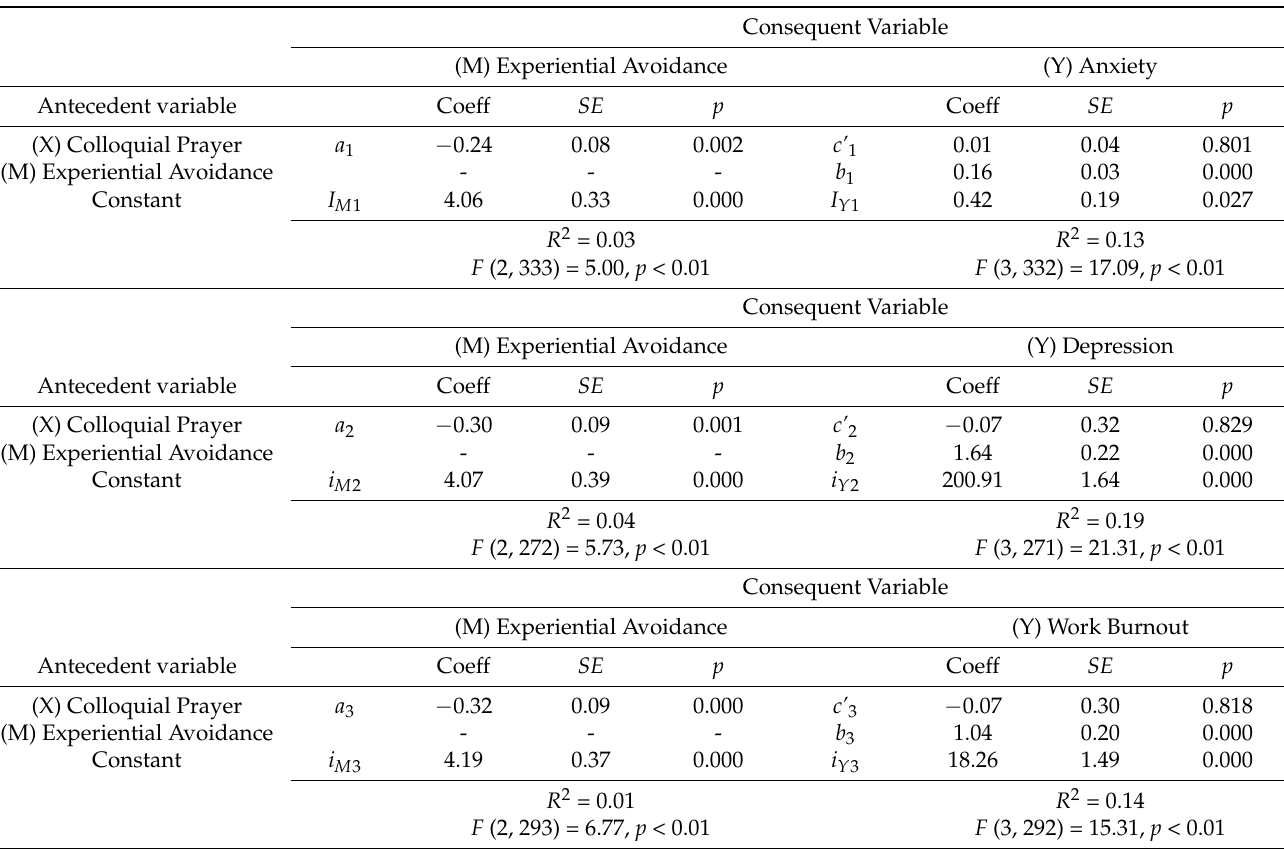
Table 4. Regression models involving colloquial prayer, experiential avoidance, and mental health symptoms.